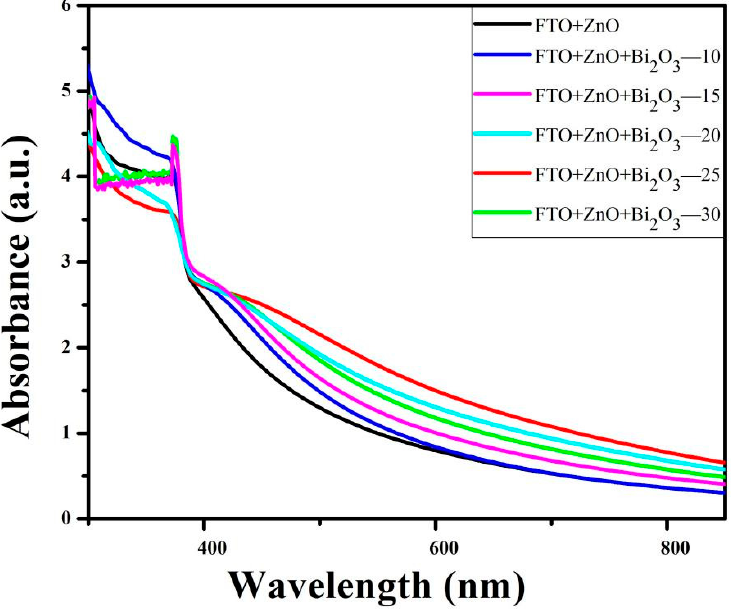
Figure 5. UV-Visible absorbance spectrum of the